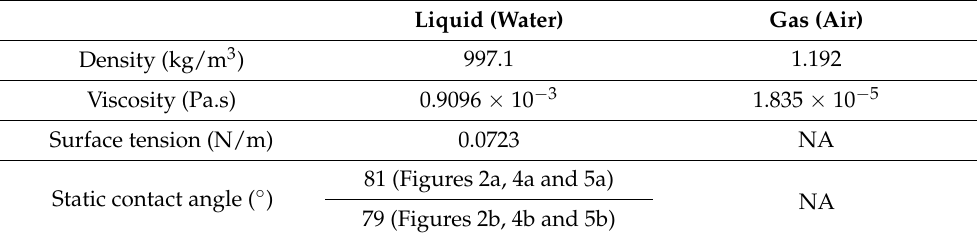
Table 2. Water and air properties at a lab temperature of 23 ◦